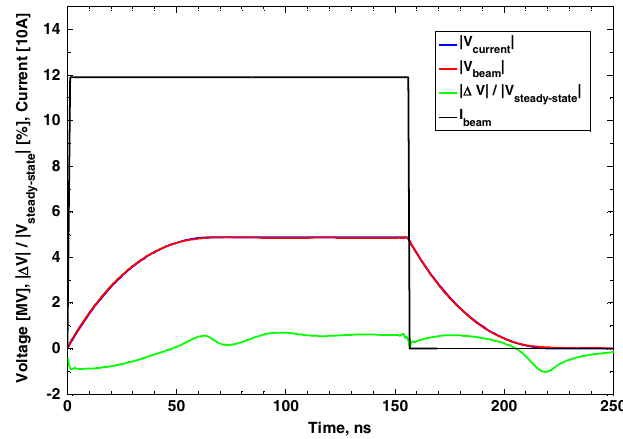
FIG. 5. Complex magnitudes of the beam voltage (red), the voltage (blue) due to the rectangular current (black) and disper- sion effect (green).